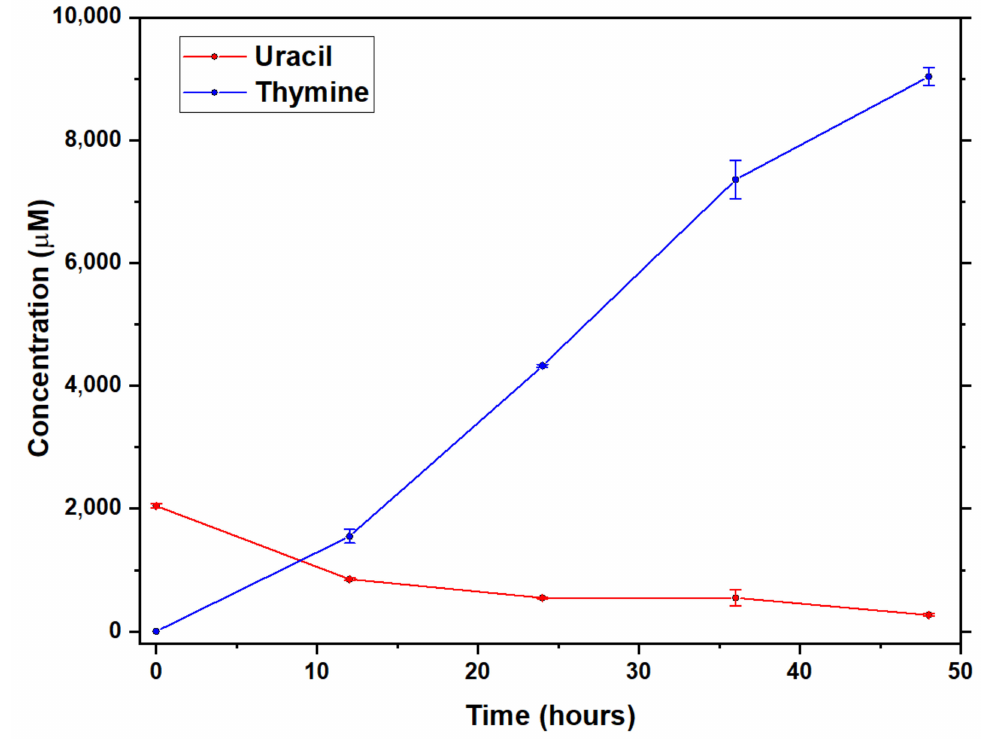
Figure 2. Time dependence of the averaged concentration of thymine and uracil in heat-treated (160 ◦ C) formamide samples containing equimolar amounts of added uracil, formic acid, and formaldehyde (2 mM each) on the beginning of incubation. The experiment was conducted in the absence of added catalysts. Standard deviations (indicated in the graph with error bars) were calculated from at least three independent